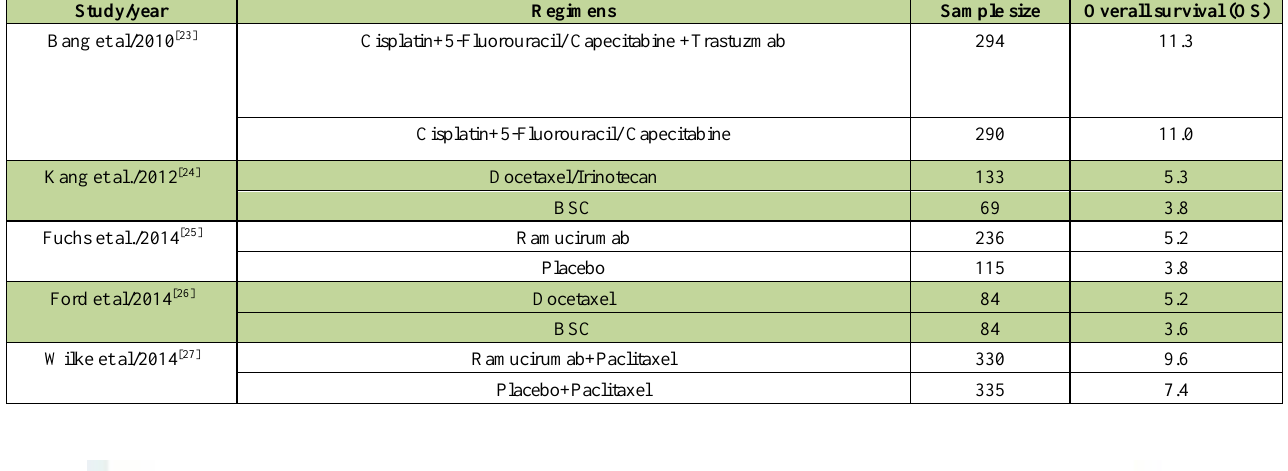
Table 2. Studies selected for Systematic Review and Meta-analysis for Chemotherapy.